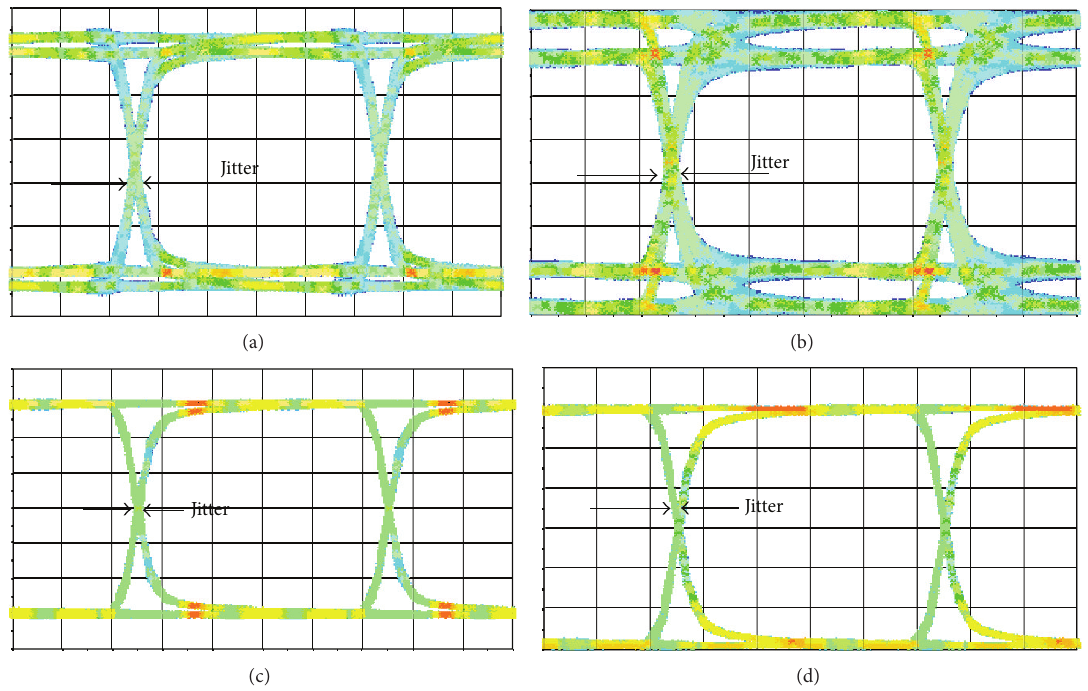
Figure 12: Eye diagram at 1Gbps PRBS: (a) parallel microstriplines; (b) microstriplines with guard trace; (c) double stub configuration; (d) parallel serpentine